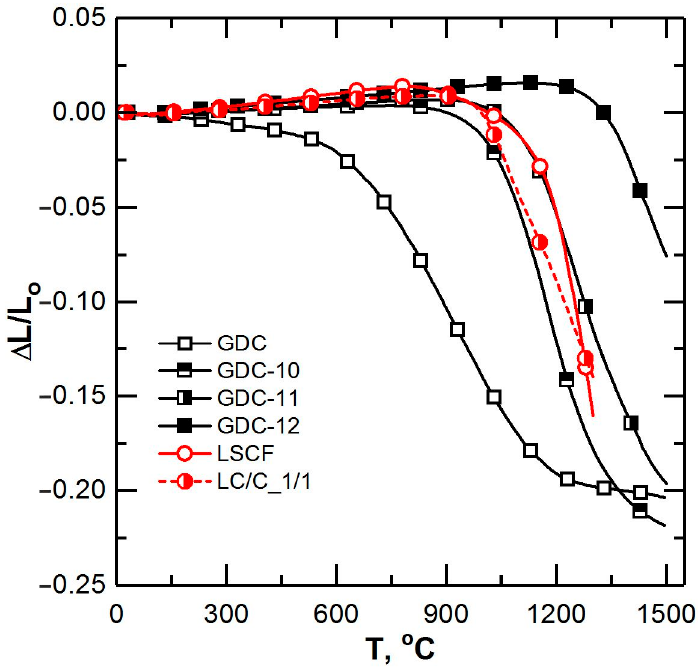
Figure 1. Linear shrinkage curves for the investigated materials. Table 2. TE С of the investigated materials.